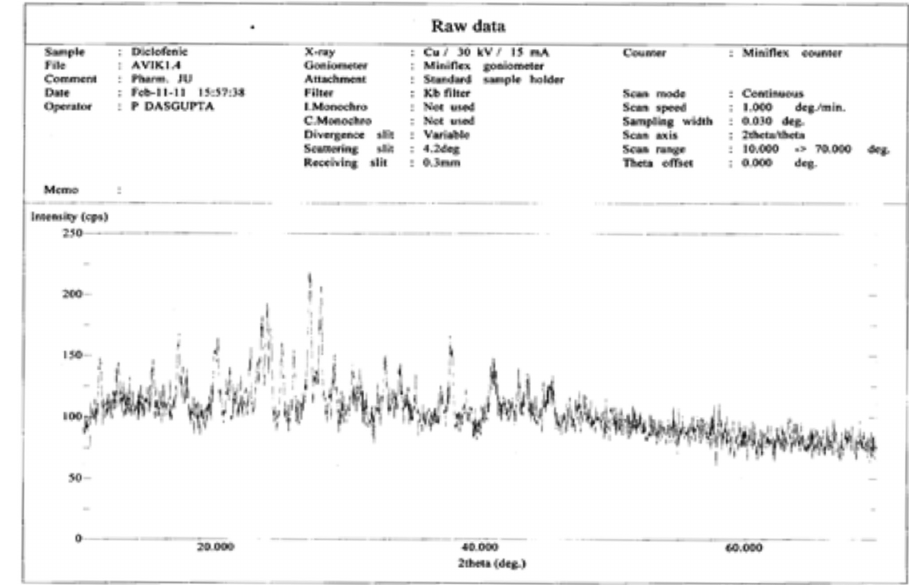
FIGURE 9 (a) - X-ray diffraction analysis of pure drug diclofenac